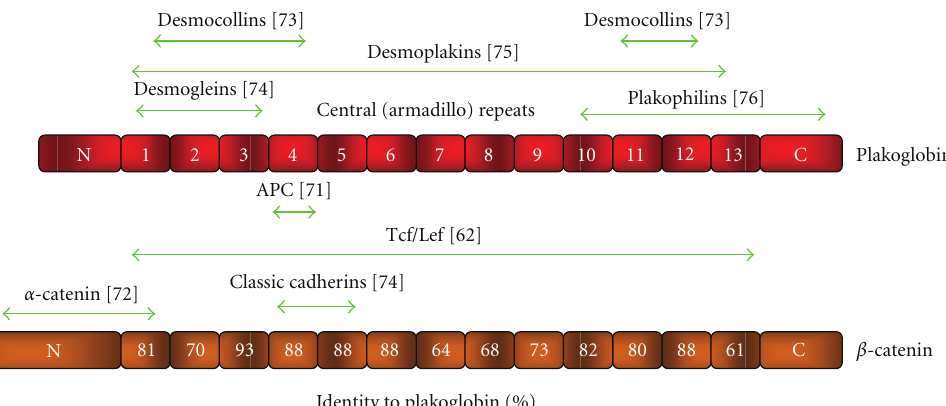
Figure 2: Schematic structure of β -catenin and plakoglobin. Both β -catenin and plakoglobin contain 13 Armadillo repeats that are flanked by N- and C-terminal domains, respectively. The degree of homology between β -catenin and plakoglobin for each Armadillo domain is indicated. Protein partners that interact with plakoglobin and the domains involved in these interactions are indicated. The corresponding references are listed in brackets (see